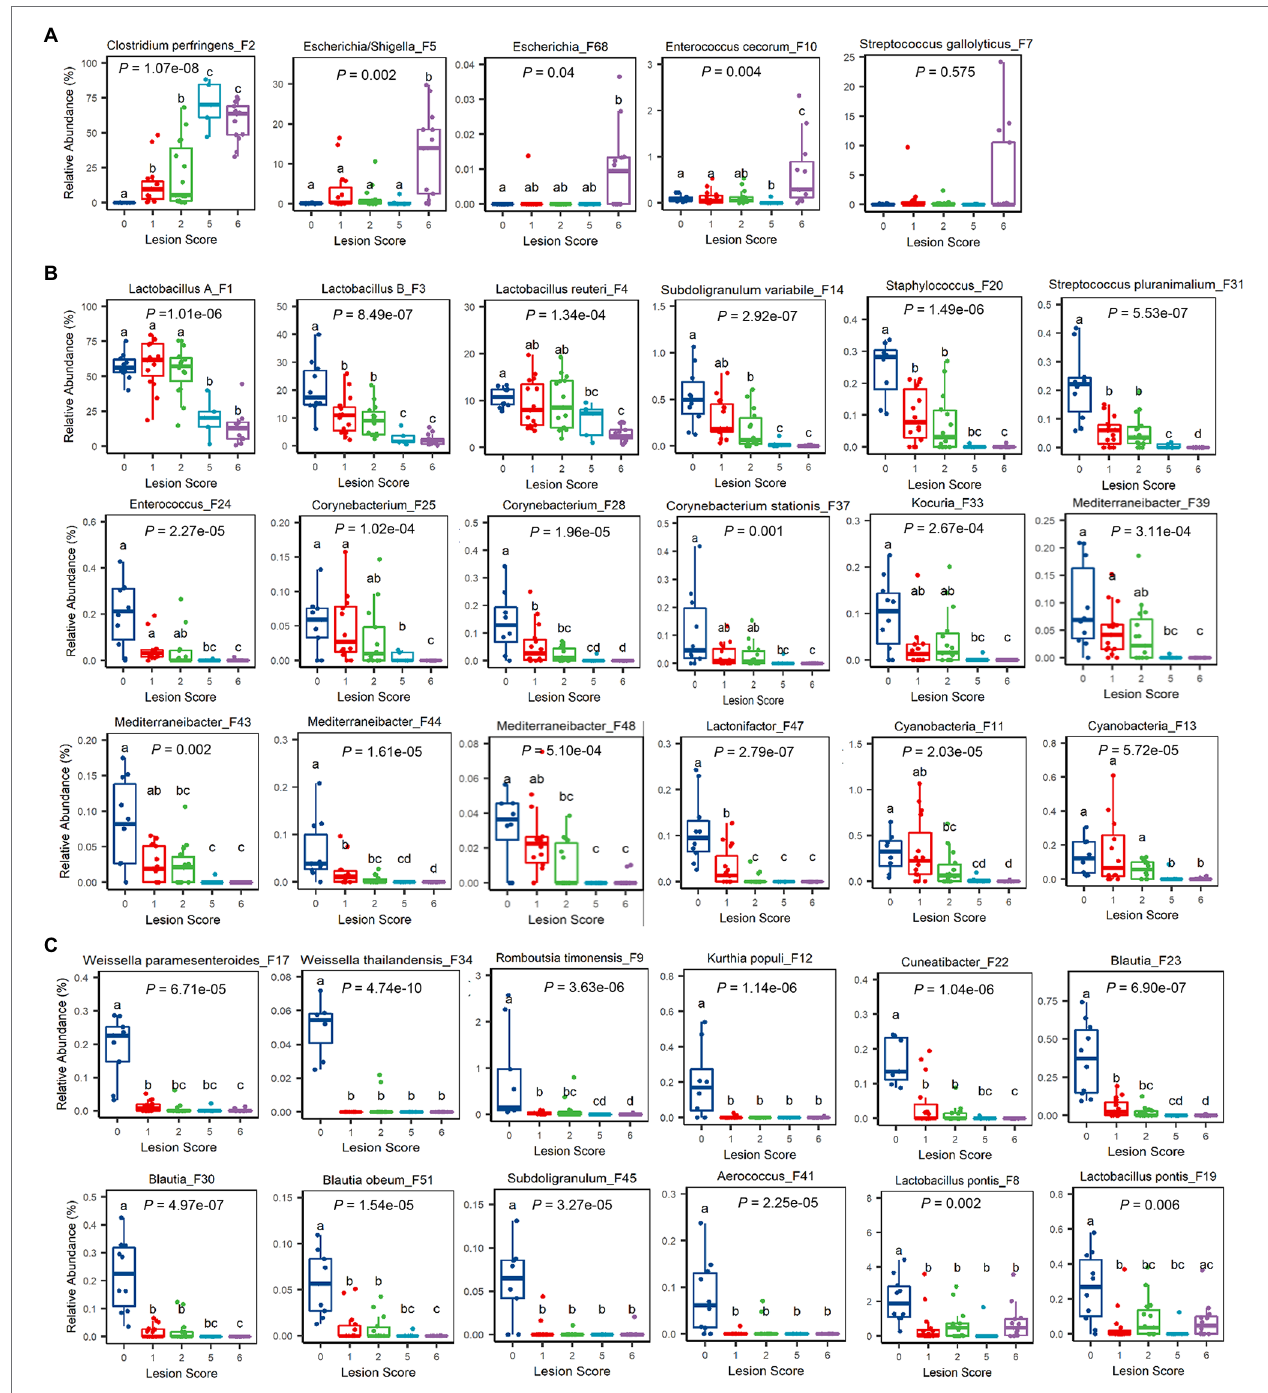
FIGURE 5 | Relative abundances of representative ileal bacteria showing a significant correlation with the severity of NE. Ileal bacteria were significantly enriched (A) , progressively declined (B) , or abruptly abolished (C) in response to NE. In the box and whisker plots, each box indicates median, 25 and 75th percentiles, while whiskers extend to 1.5 interquartile range. Significance was measured using the Kruskal-Wallis test and indicated on the top of each plot. Pairwise comparisons were further implemented using the Wilcoxon rank sum test, and the significance ( p < 0.05) was denoted by different